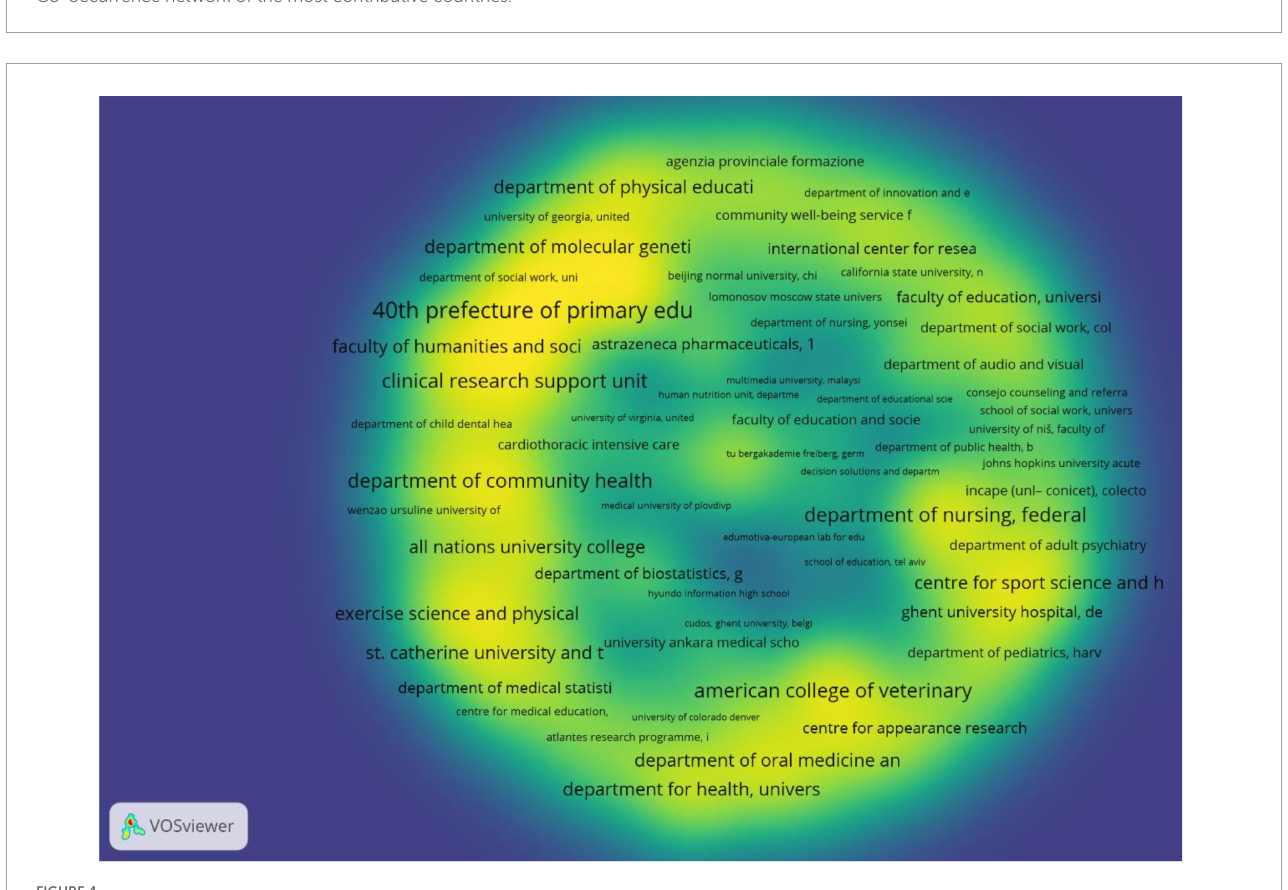
FIGURE4 Density visualization map of the most contributive